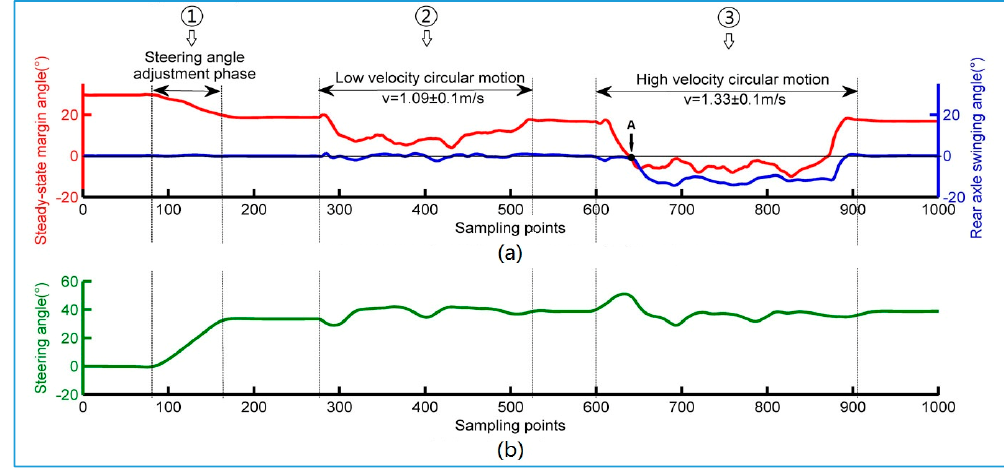
Figure 18. Uniform circular motion test data. ( a ) Steady-state margin angle and rear axle swinging angle curve; ( b ) Steering angle curve.